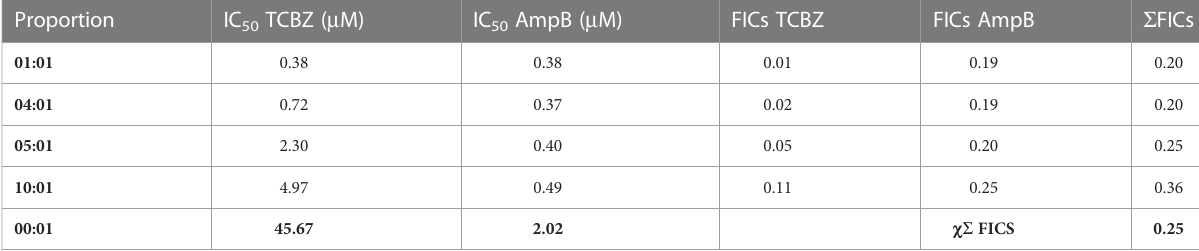
TABLE 3 IC 50 of intracellular amastigote forms in each proportion analyzed (1:1, 4:1, 5:1, 10:1 for TCBZ and AmpB, respectively).